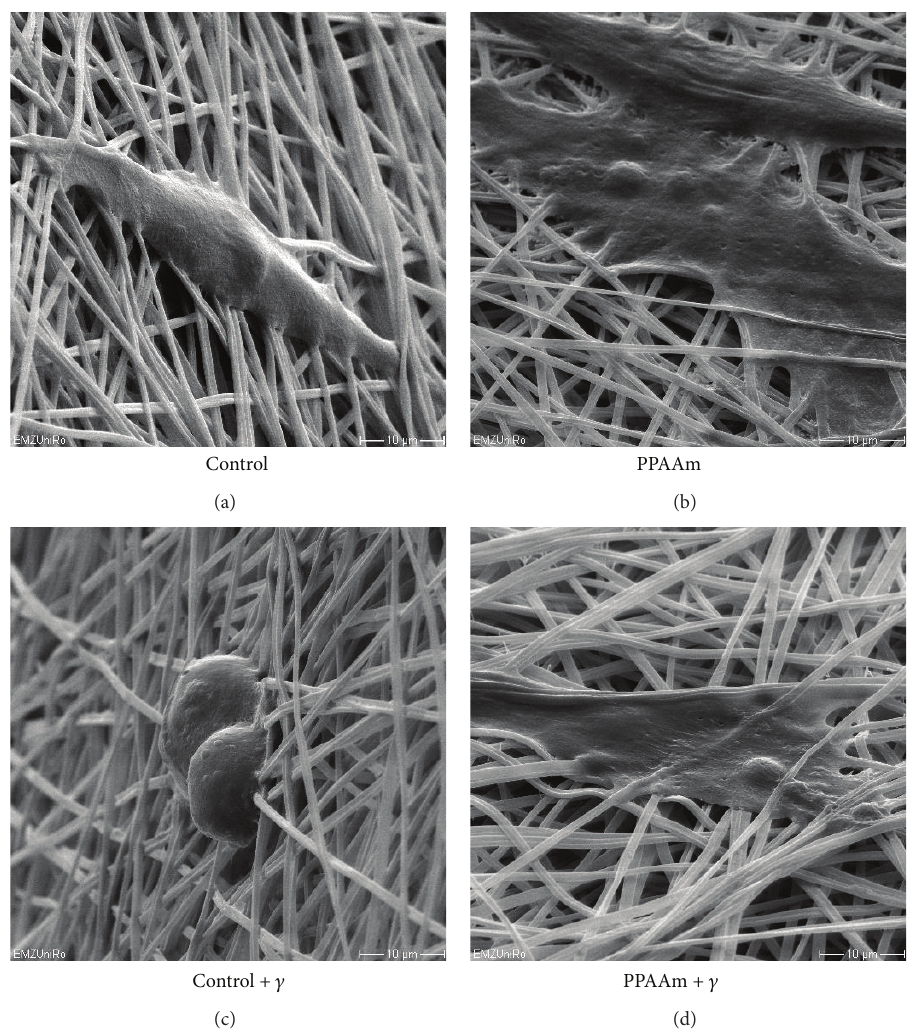
Figure 9: SEM images of test cells (MG-63) growing for 24 h on untreated and PPAAm-coated PLA meshes before (upper row) and after 𝛾 -sterilization (lower row). Note that the process of sterilization did not disturb the spreading promoting effect of PPAAm inside the mesh (right, below).